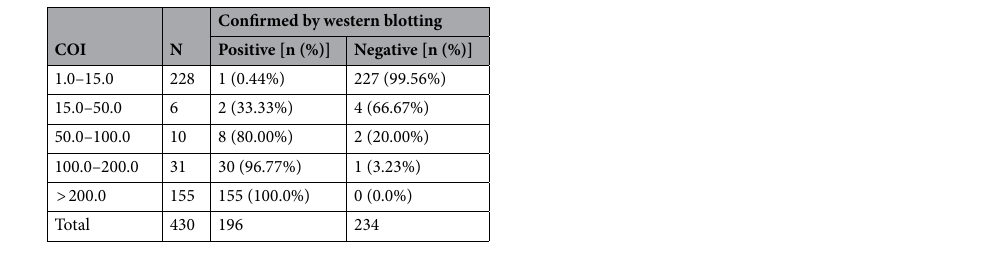
Table 1. Distribution of screening values of COIs in false-positive and positive specimens. COI cut-off